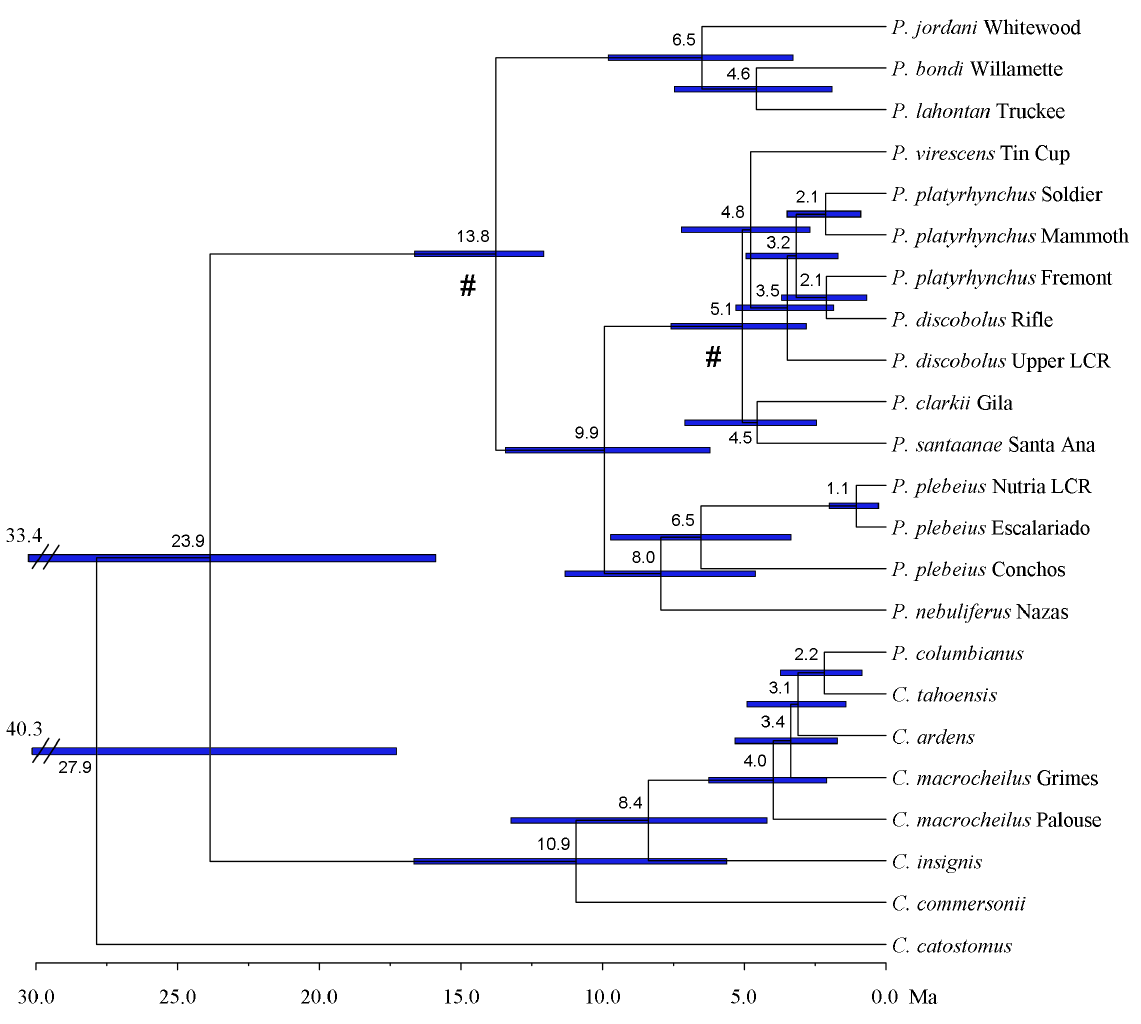
Figure 5. Bayesian molecular clock estimates for Pantosteus based on analysis of mitochondrial DNA. Horizontal bars represent the 95% highest posterior density ranges. Locality details are provided in Table 1, OTU order and labels match those in Fig. 3.